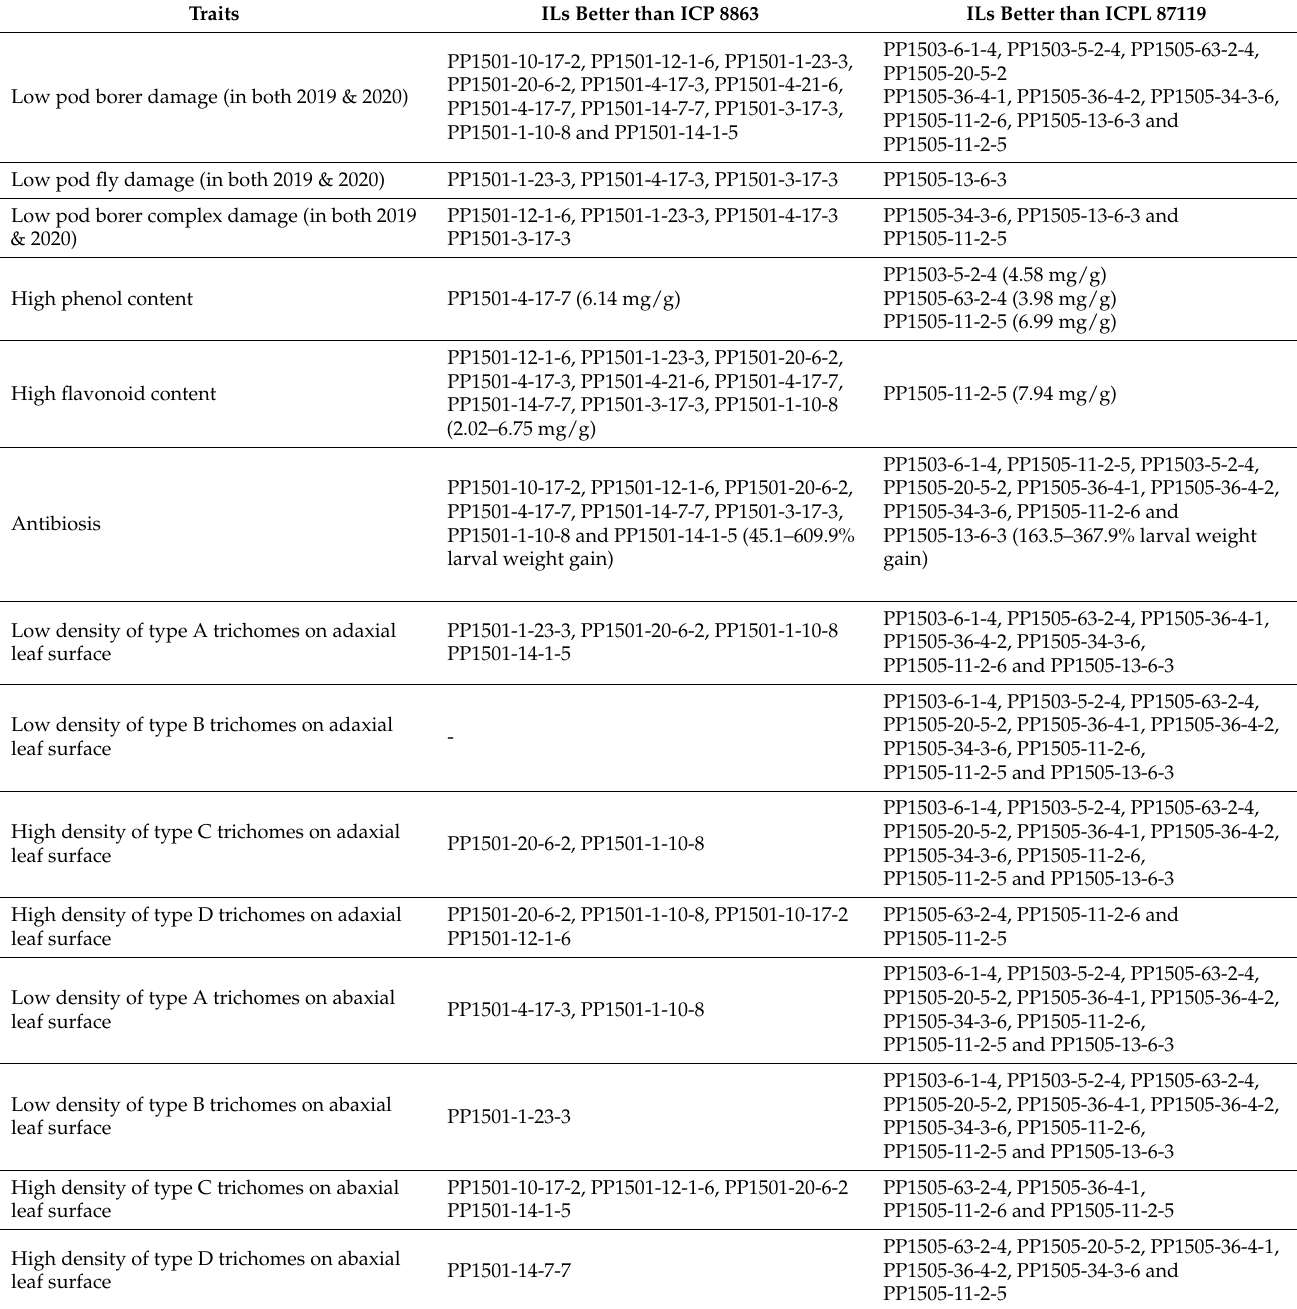
Table 5. Trait-specific promising introgression lines (ILs) selected from 39 ILs derived from wild Cajanus species for use in pigeonpea